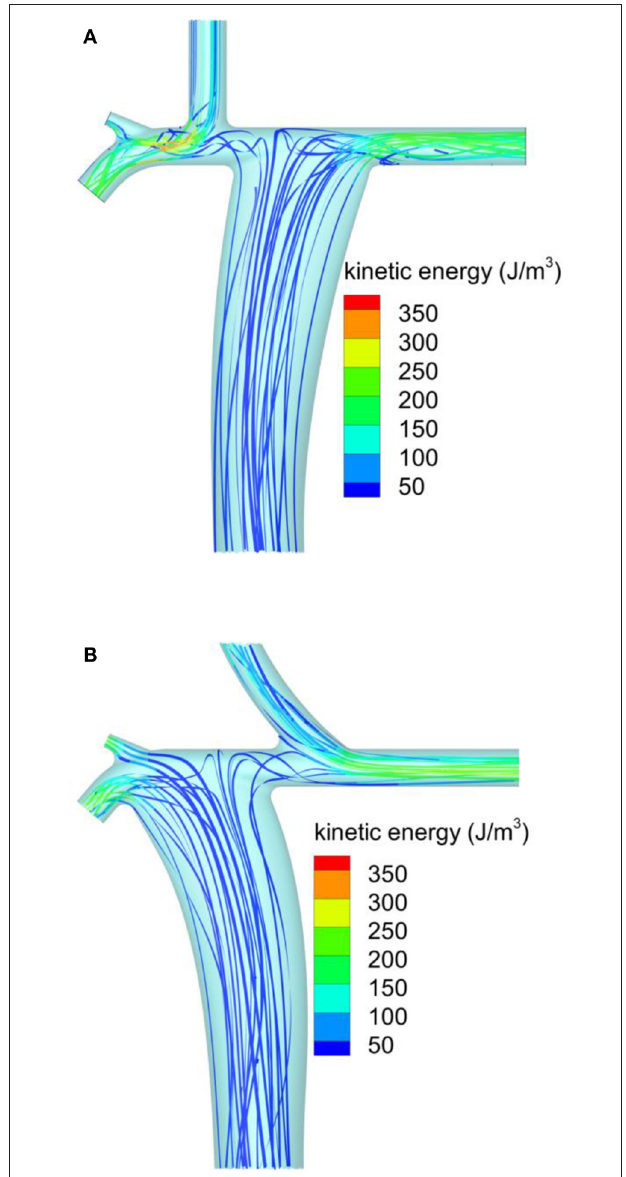
FIGURE 3 | Streamlines predicted by CFD colored by the flow kinetic energy per unit volume: (A) conventional extracardiac Fontan; (B) new physiological